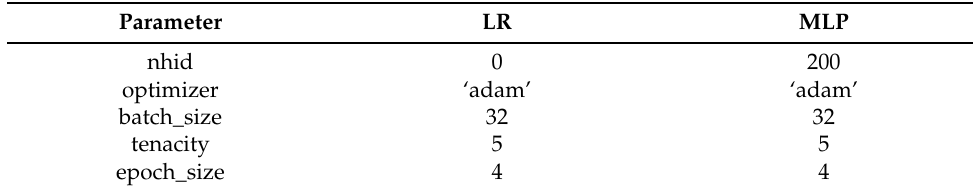
Table 6. Parameters for the Classifiers.